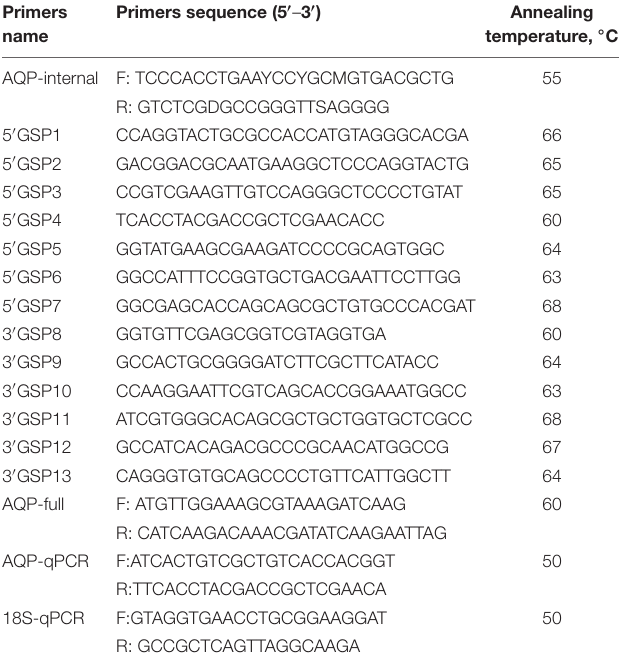
TABLE 1 | Primers used in this